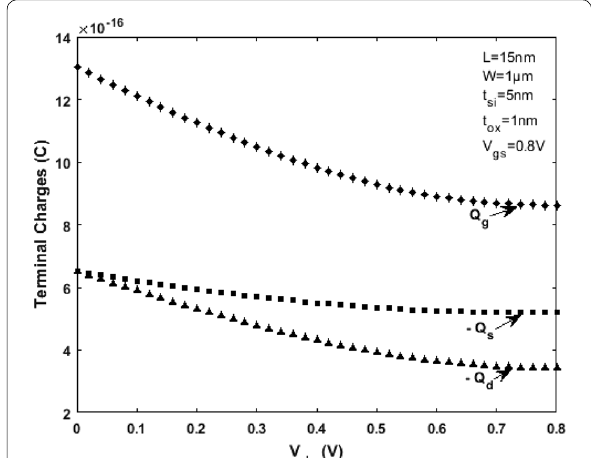
Fig. 7 Variation of Drain current I ds as a function of V gs for V ds in a SDG MOSFET Fig. 8 Variation of terminal charges as a function of drain voltage V